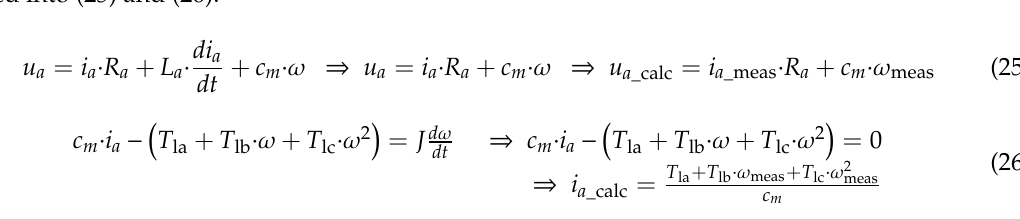
Table 18. Calculated current and speed using (25) and (26) and their deviation at selected points for MD1, MD2, MD3, and MD4 for calculated parameters obtained with RK.